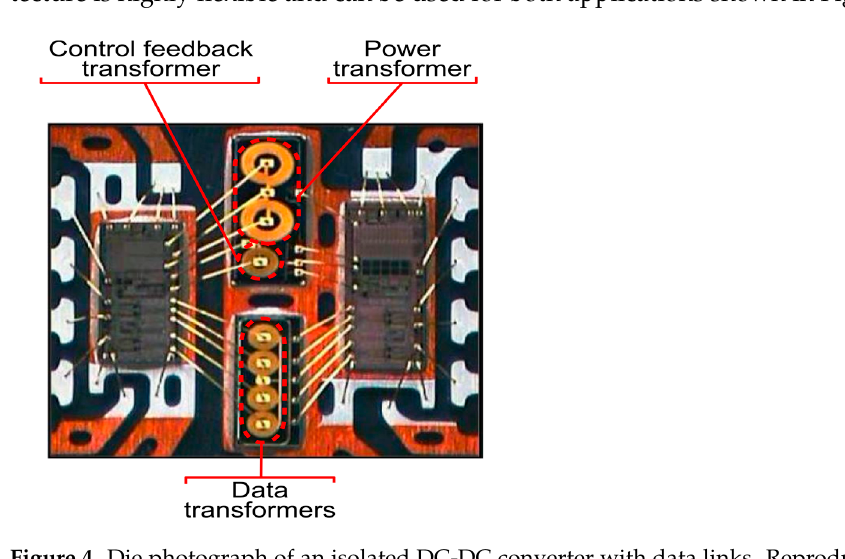
Figure 5. Architectures for galvanically isolated power/data transfer systems: ( a ) Traditional [19]. ( b ) In [20]. ( c ) In [21]. ( d ) In [22]. ( e ) In [23]. Reproduced from [17]. Copyright 2019, IEEE. 2.1. Triple Transformer Architecture for Low-Power Isolated ADC The traditional architecture in Figure 5a can be simplified by getting rid of the dedi- cated control link for power regulation. Indeed, the control bit stream can be multiplied along with the data stream (from B to A) on the same physical isolated link. Typically, this is compatible with most DC–DC applications, since the bitrate for power regulation is quite low and, hence, data multiplexing does not significantly degrade the overall perfor- mance. Of course, bidirectional communication requires a third dedicated data link (from A to B). Basically, a triple transformer architecture includes a power transformer and two data transformers for bidirectional communication, while multiplexing data, along with the control bits on the same transformer (from B to A). A triple transformer architecture has been demonstrated in an isolated delta–sigma ADC for shunt-based current sensing in [20]. The isolated ADC was implemented with a SiP approach, by means of polyimide power/data transformers providing 5-kVrms isola- tion (see Figure 6 for cross-section and the top-view of the isolation power transformer). The block diagram and the die photograph of the isolated ADC with triple transformers are shown in Figure 7a,b, respectively. This solution can be simplified into a double trans- former architecture by eliminating a data transformer, only for the applications in which bidirectional communication is not required.